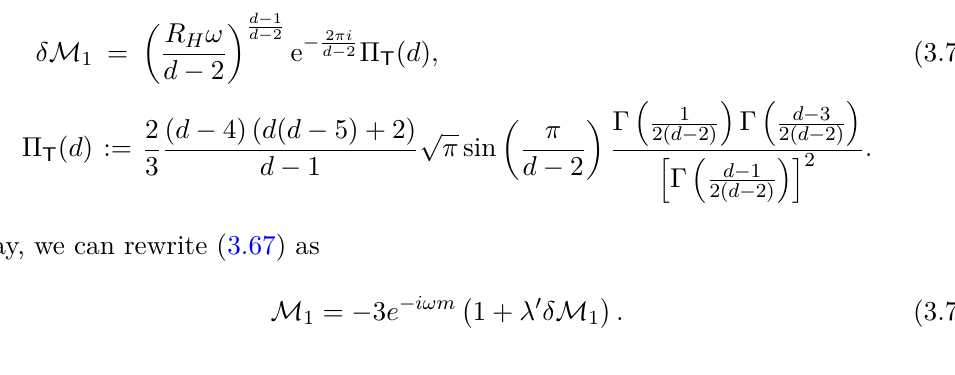
. The Stokes lines H